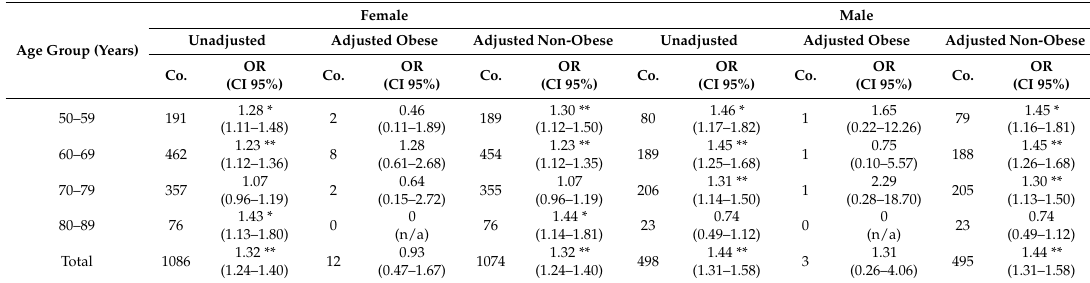
Table 1. The co-occurrence and the OR for the association between T1DM and KOA observed among various age groups of both genders in the Taiwanese population. Co.: co-occurrence, OR: odds ratio, n/a = not available. * and ** indicate p -value less than 0.05 and 0.0001, respectively. Female Male Unadjusted AdjustedObese AdjustedNon-Obese Unadjusted AdjustedObese AdjustedNon-Obese AgeGroup(Years) Co.